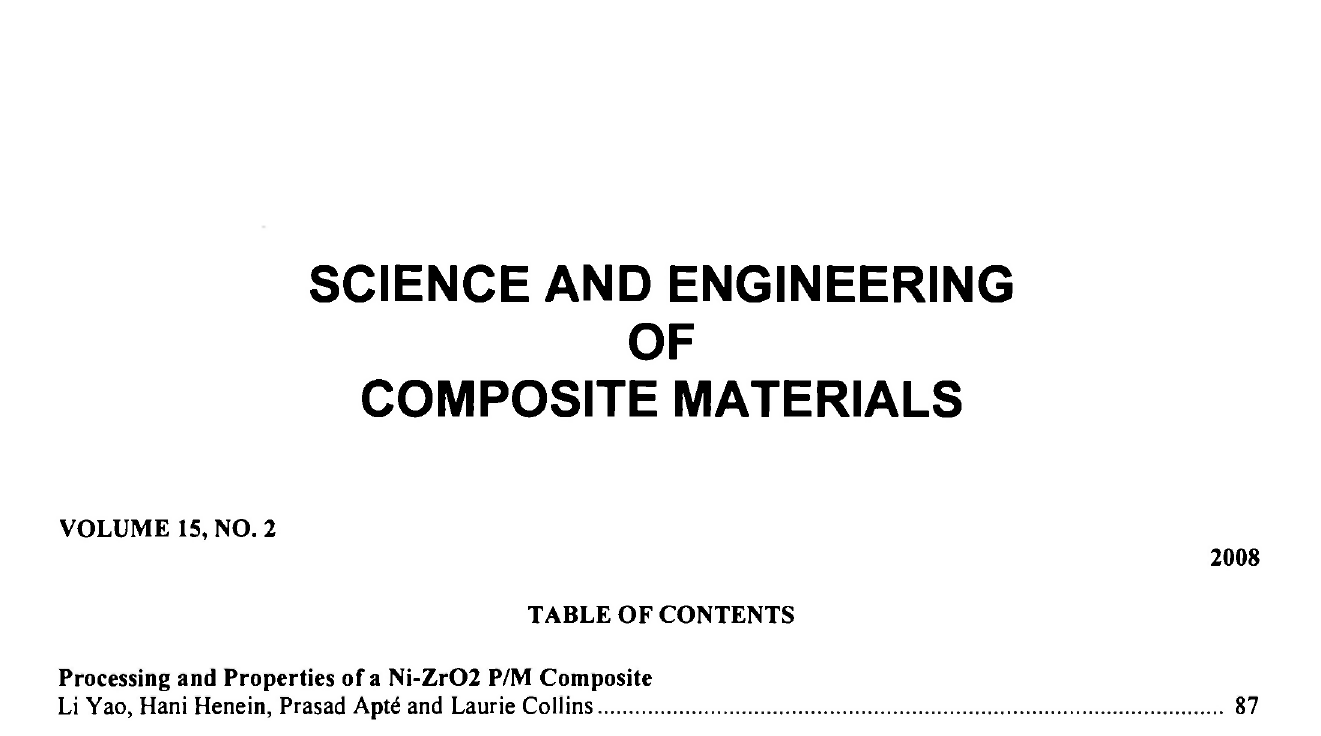
Processing and Properties of a Ni-Zr02 P/M